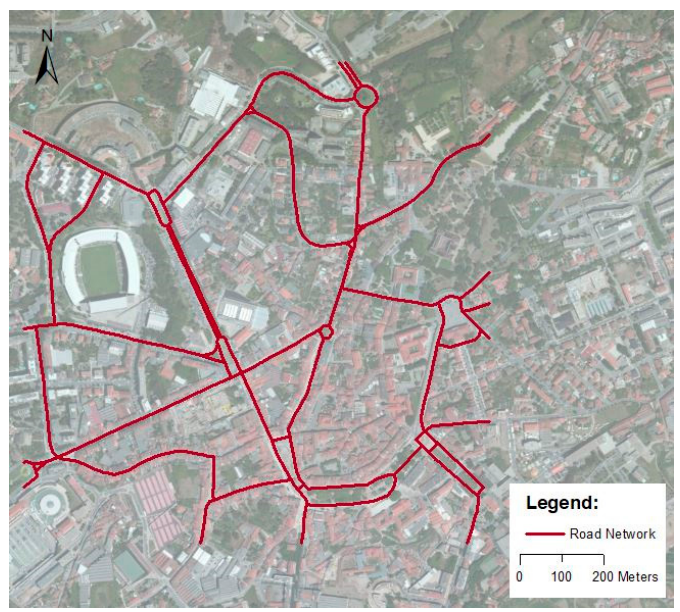
Figure 2. City center of Guimarães and the streets included in the noise maps.